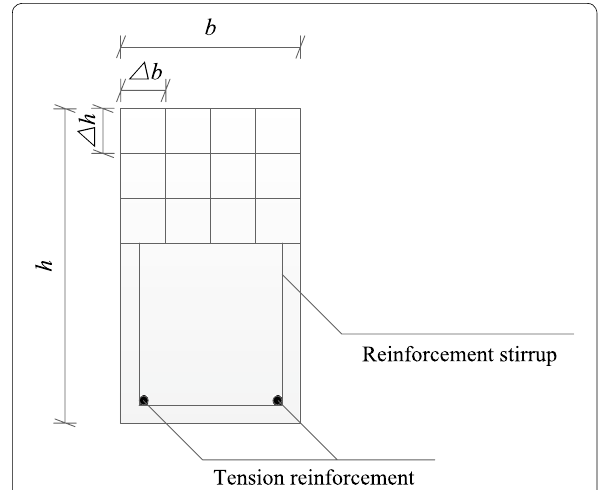
Fig. 3 Element division of post‑fire beam